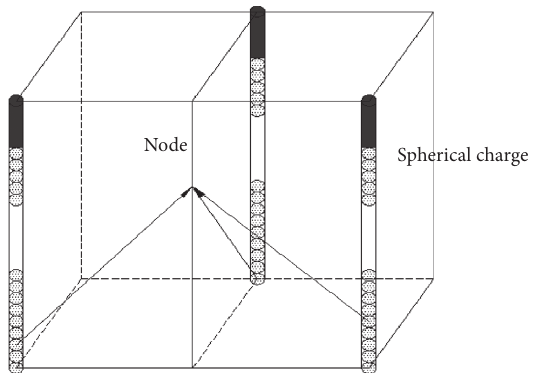
Figure 2: Cylindrical charge as near as possible or equal to the spherical charge.